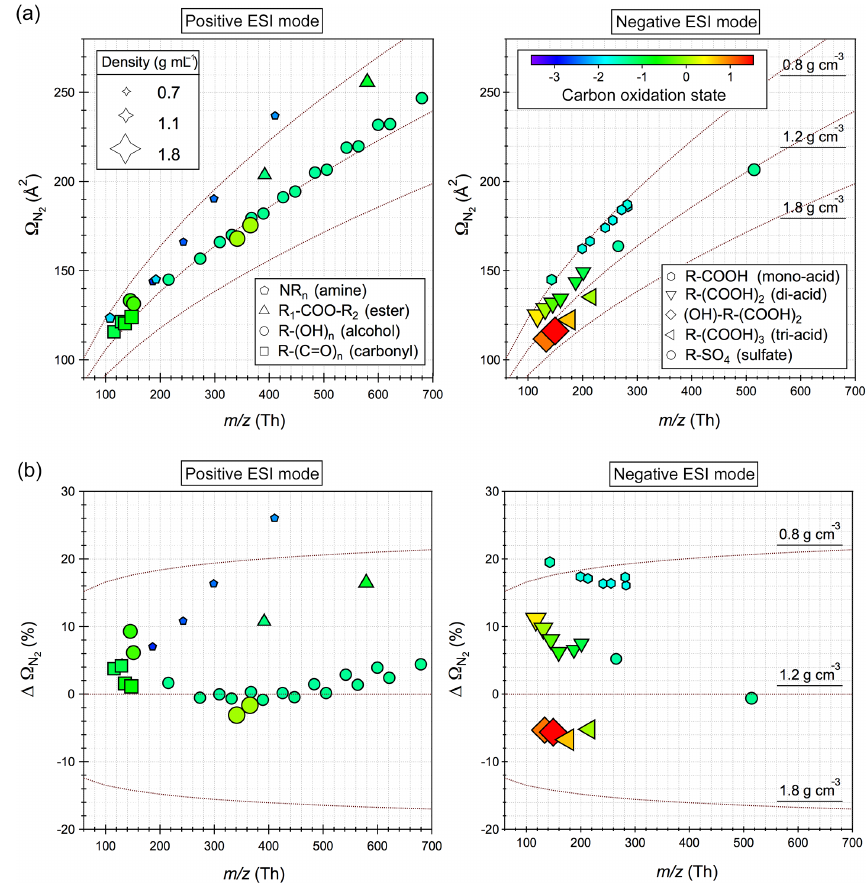
Figure 1. Distribution of organic species including alcohol (R-(OH) n , n = 2 − 8), amine (NR 3 ) , quaternary-ammonium (NR 4 ) , carbonyl (R- (C = O) n , n = 1 − 2), carboxylic acid (R-(COOH) n , n = 1 − 3), ester (R 1 -COO-R 2 ) , organic sulfate (R-SO 4 ) , and multifunctional compounds − m/z space and (b) (cid:49)(cid:127) N − m/z space. Note that species that are detected in different ion modes ( ± ) ((OH)-R-(COOH) 2 ) on the (a) (cid:127) N 2 2 are plotted separately.